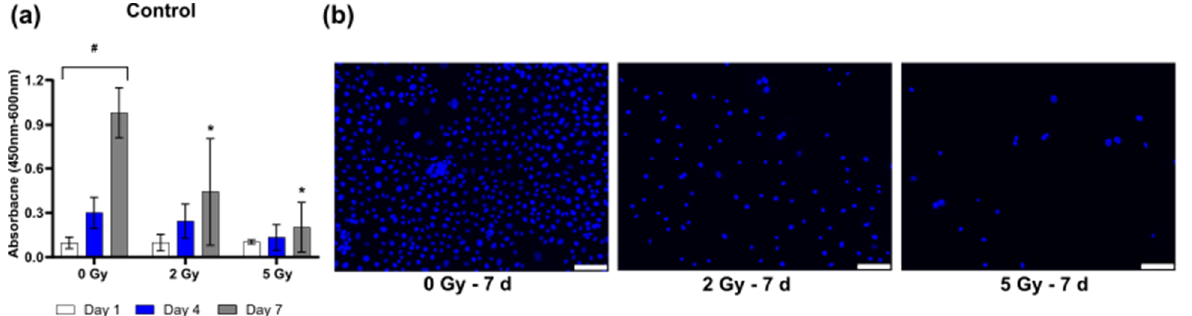
Figure 1. Keratinocyte viability after irradiation of the control groups without growth factor treatment: ( a ) Y–axis shows absorbance on 1 d, 4 d, and 7 d after 0, 2, 5 Gy irradiation; ( b ) representative images of irradiated keratinocytes without growth factor supplementation at time point 7 d stained with DAPI (blue = living cells). * p ≤ 0.05, significances were correlated to the non-irradiated respective control. * = significant compared to the control without growth factors in the respective irradiation dose at the respective time point. # = significances were correlated to the control on day 1. Scale bar 100 µm.